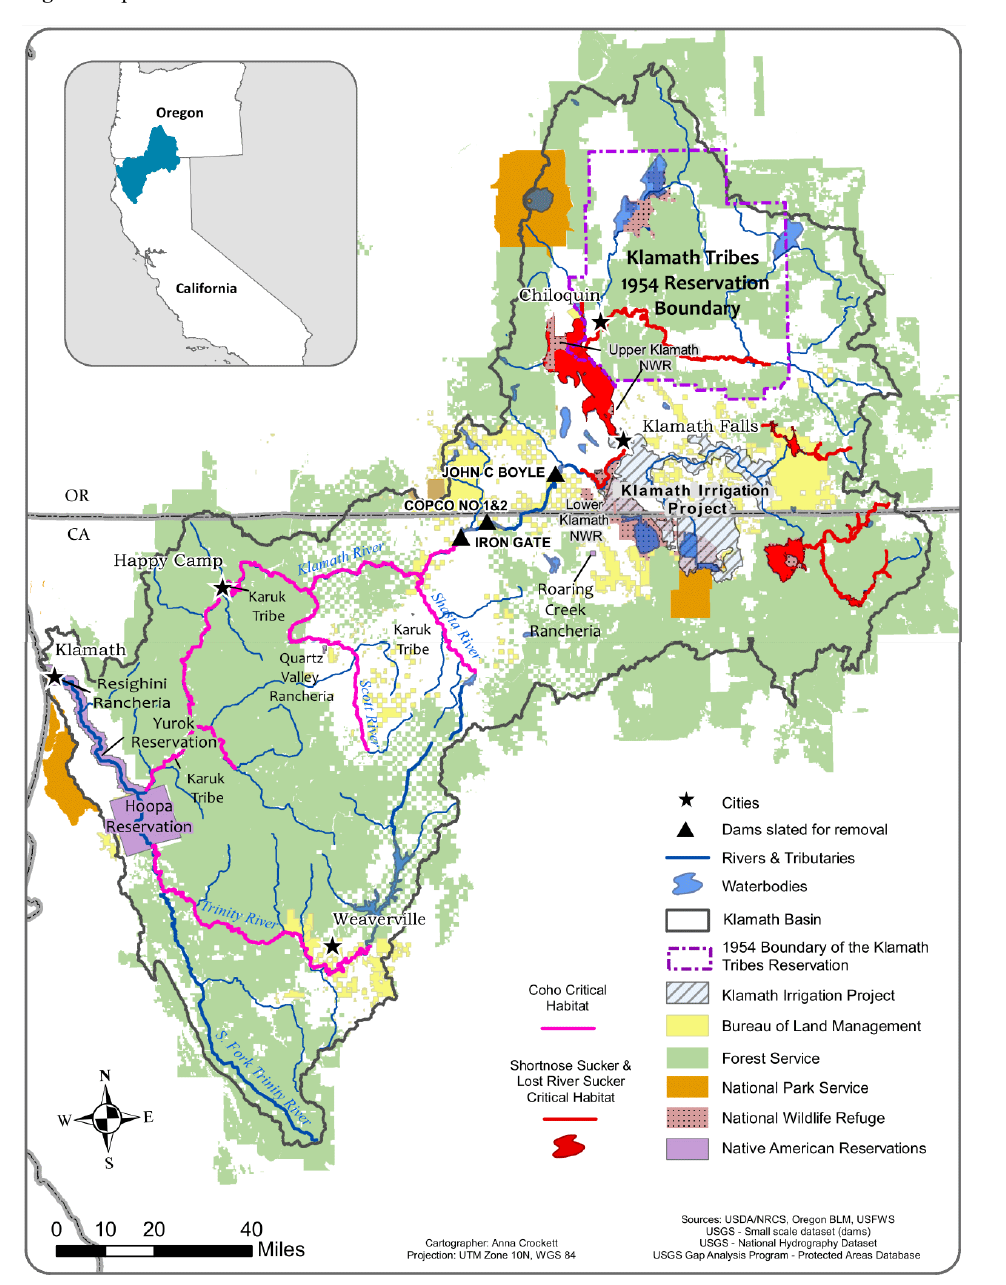
Fig. 1 . Map of the Klamath